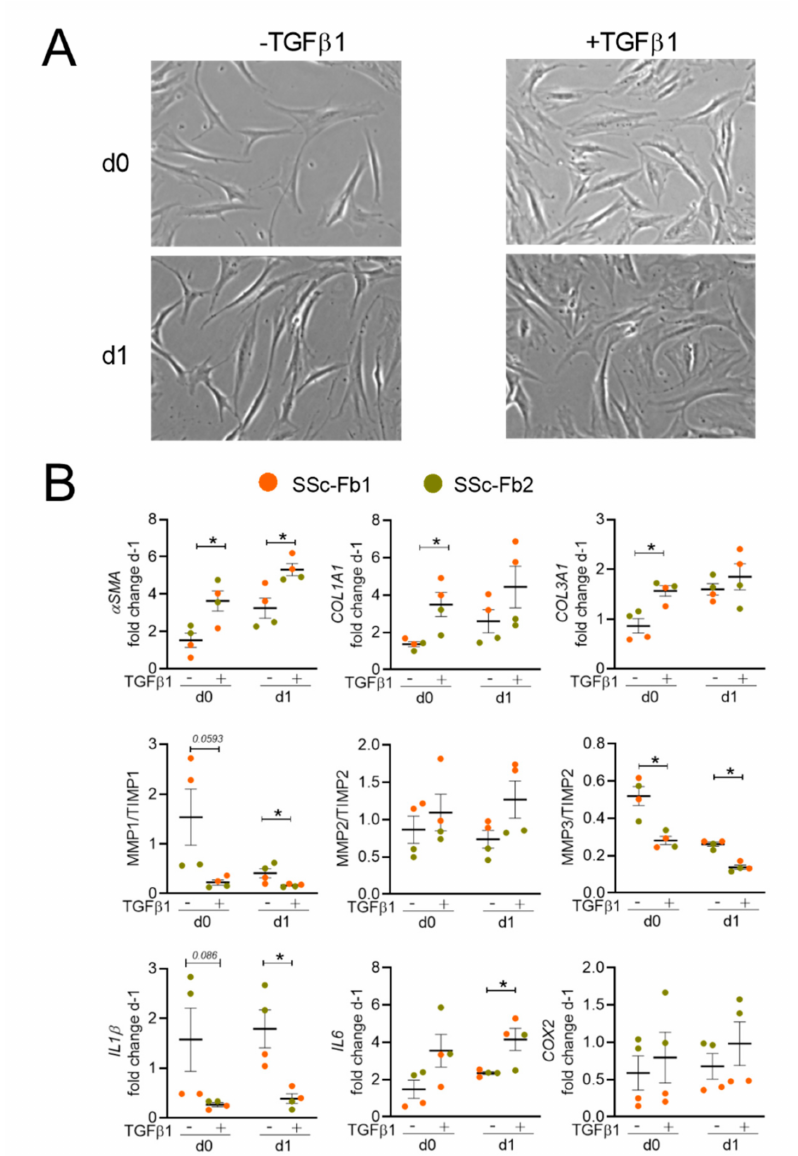
Figure 2. The phenotype of fibroblasts isolated from systemic sclerosis (SSc) patients. ( A ) Representa- tive pictures of fibroblasts from SSc patients (SSc-Fb) cultured with or without TGF β 1 on days 0 and 1 after stimulation ( × 40 objective). ( B ) Fold change of gene expression normalized on day-1 ( n = 4). *: p <